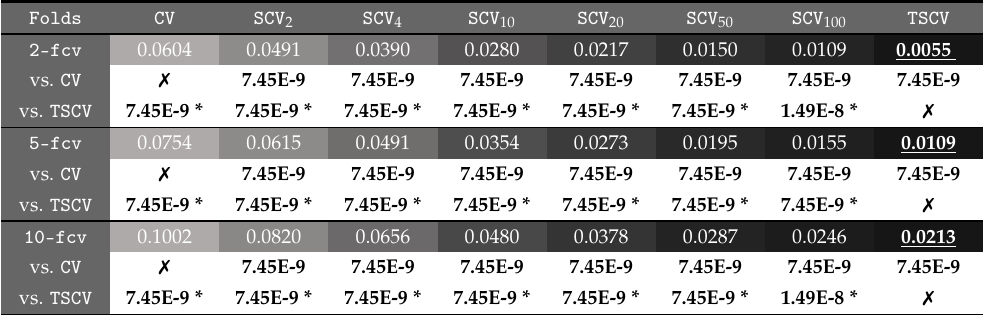
Table 4. Induced target shift by different k -fcv schemes. A darker background in the results indicates that these are better. Those cases in which the method of the row obtains a higher sum of ranks than that of the column in Wilcoxon ’s test are indicated with an